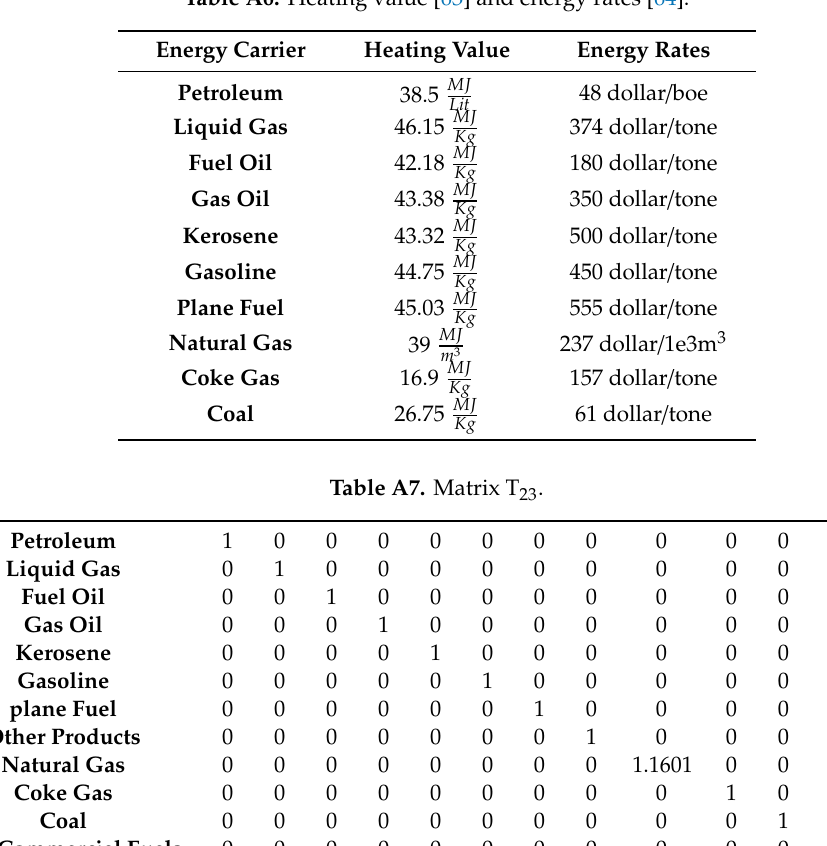
Table A6. Heating value [63] and energy rates [64].